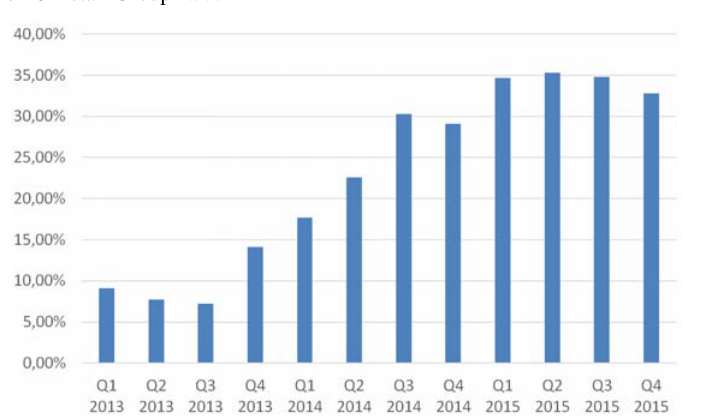
Fig. 3. Net retail sales growth of the “Pyaterochka”